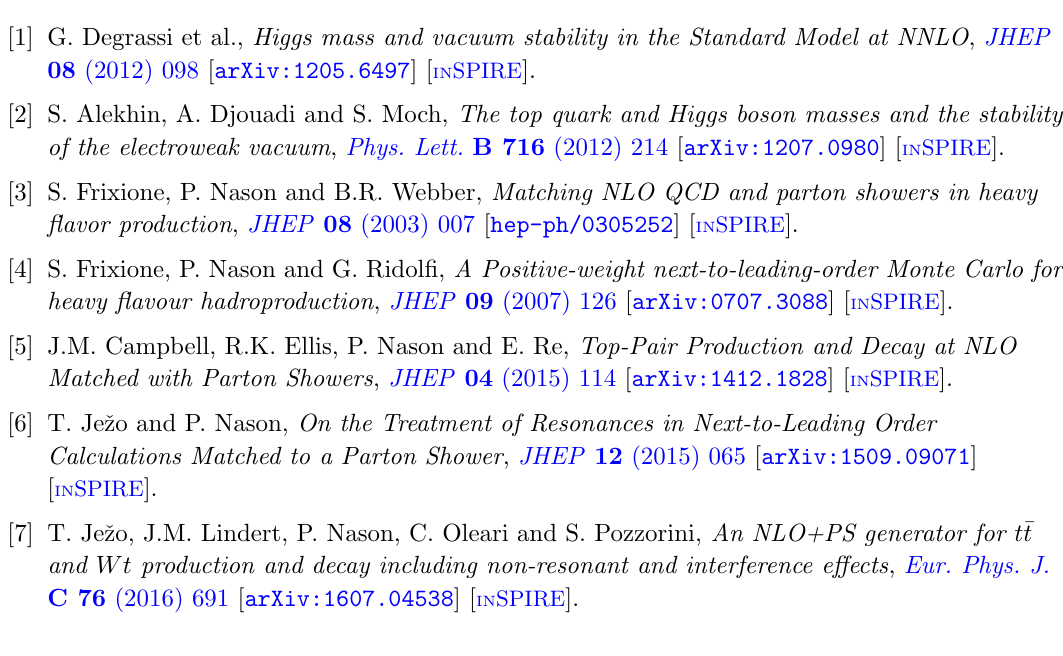
Figure 19 . Normalised H T di(cid:11)erential distribution at NLO QCD for the pp ! e X production process at the LHC with p s = 13 TeV. Three di(cid:11)erent theoretical descriptions with m t = 173.2 GeV are shown. Also given are the relative size of NLO QCD corrections and the combined relative size of (cid:12)nite-top-width and (cid:12)nite-W-width e(cid:11)ects for the normalised H T observable. Renormalisation and factorisation scales are set to the common value (cid:22) R = (cid:22) F = (cid:22) 0 where (cid:22) 0 = m t . The CT14 PDF set is